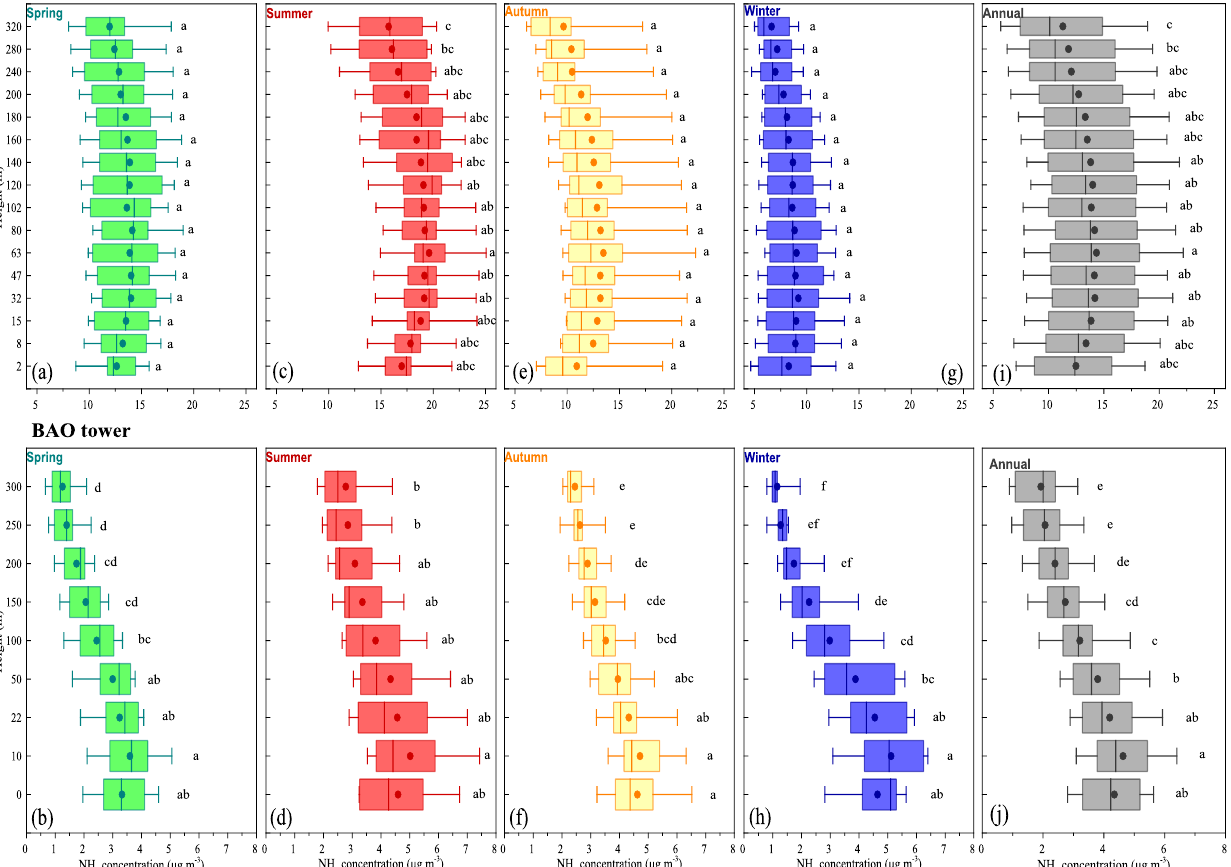
Figure 3. Comparison of seasonal vertical NH 3 concentrations with the mean (dots), median, 10th, 25th, 75th and 90th percentiles of the NH 3 concentrations of each height for the IAP tower (Beijing, this study; a, c, e, g, i) and BAO tower (USA, Li et al., 2017; b, d, f, h, j) . The lowercase letters next to the boxes denote the statistical difference in the NH 3 concentration between all heights, where a one-way ANOVA was used, at the p < 0 . 05